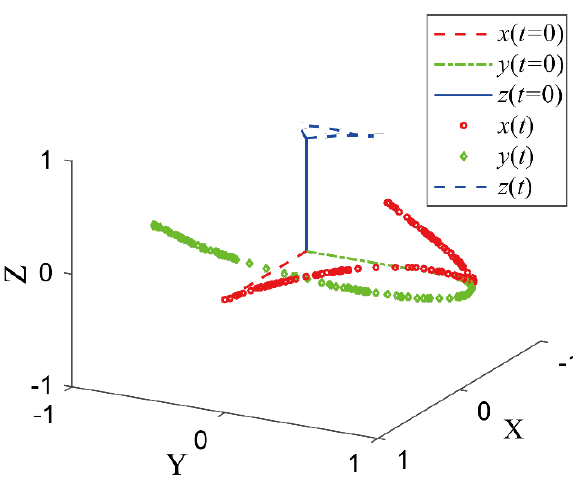
Figure 6. The 3D representation of the time-optimal reorientation for Case 1.